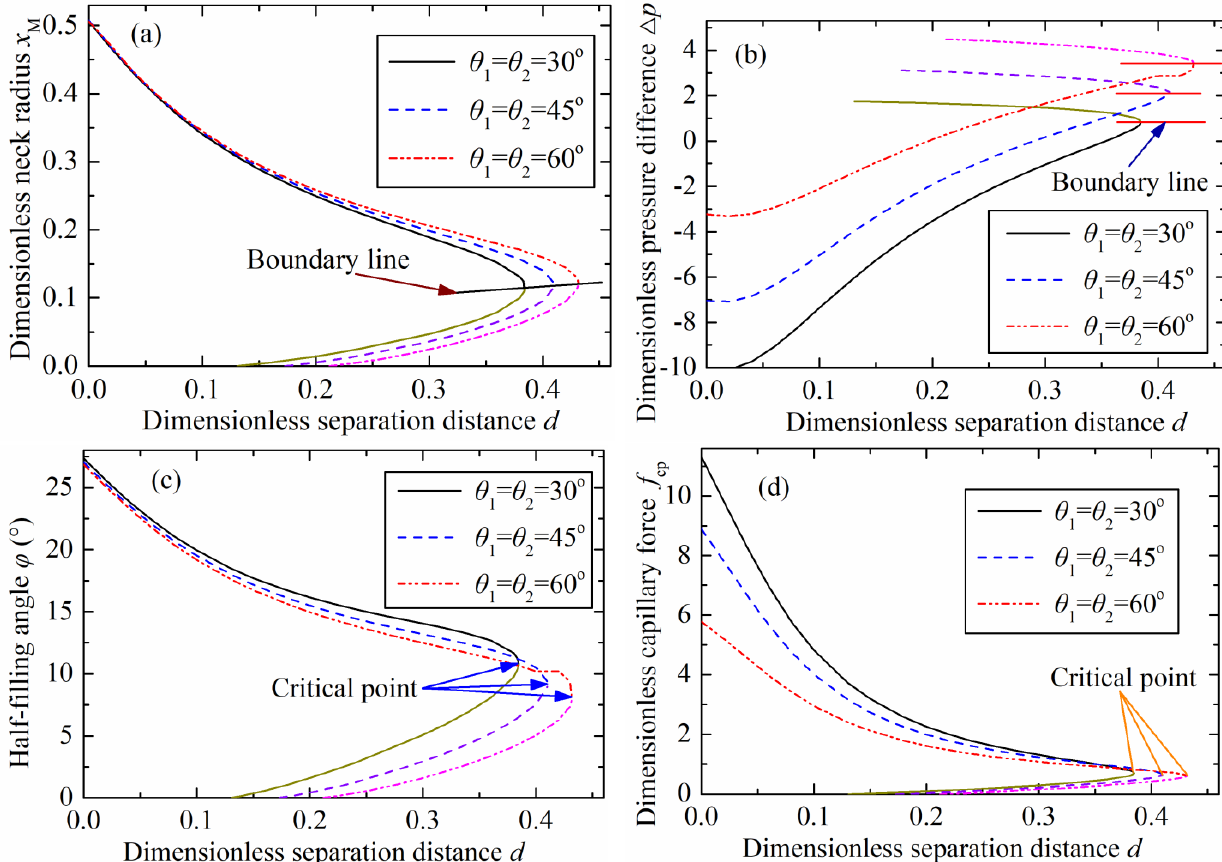
Figure 3. Various parameters changing with dimensionless separation distance variation at three contact angles: ( a ) dimensionless neck radius, ( b ) dimensionless pressure difference, ( c ) half-filling angle, and ( d ) dimensionless capillary force.